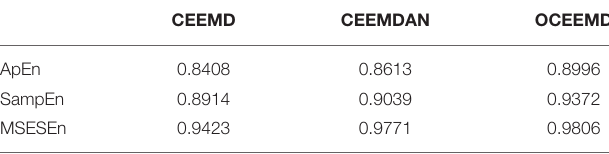
TABLE 4 | R 2 with different